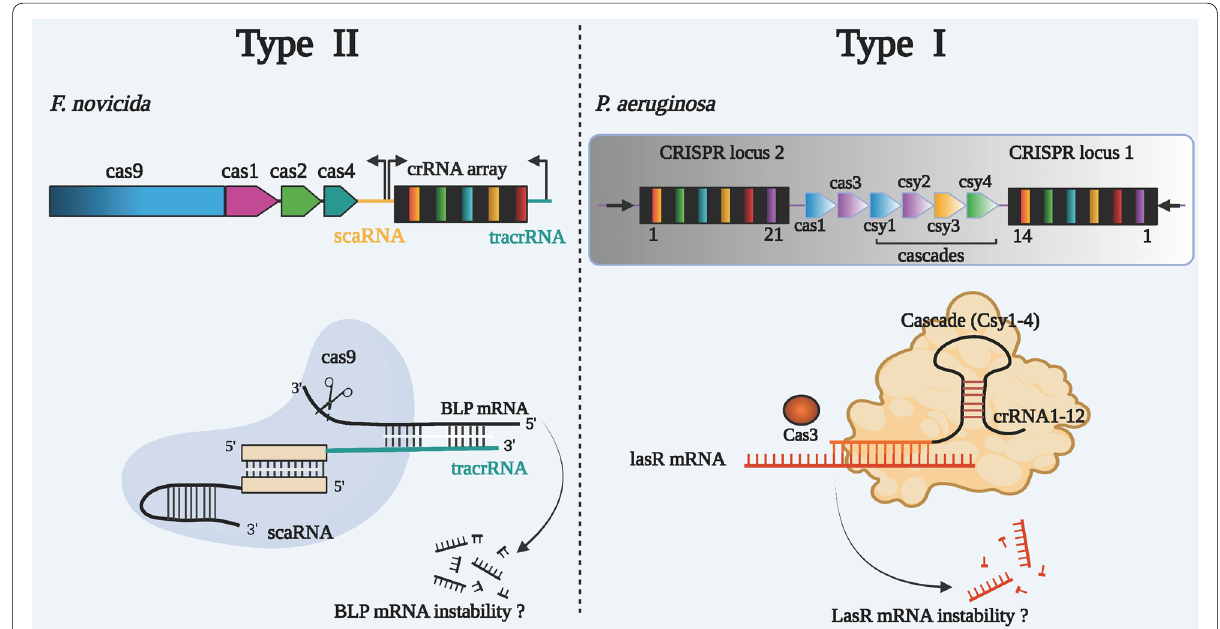
Fig. 3 Type II and type I CRISPR-Cas systems adjust the expression of endogenous transcripts. TracrRNA and scaRNA (small, CRISPR-Cas-associated RNA) form a dual-RNA complex through sequence recognition to the CRISPR repeats. This dsRNA structure enables the free terminal of the tracrRNA to interact through a non-identity matching mRNA encoding the BLP, the stability of BLP mRNA is impeded and thereby leading to the degradation of mRNA. Type I CRISPR-Cas system of PA14 targets the mRNA of the QS regulator LasR. The crRNA1-12 structure is associated with Cascade (Csy1-4 complex) and interacts with lasR mRNA through a sequence complementing a part of crRNA1-12, and resulting in lowered lasR mRNA